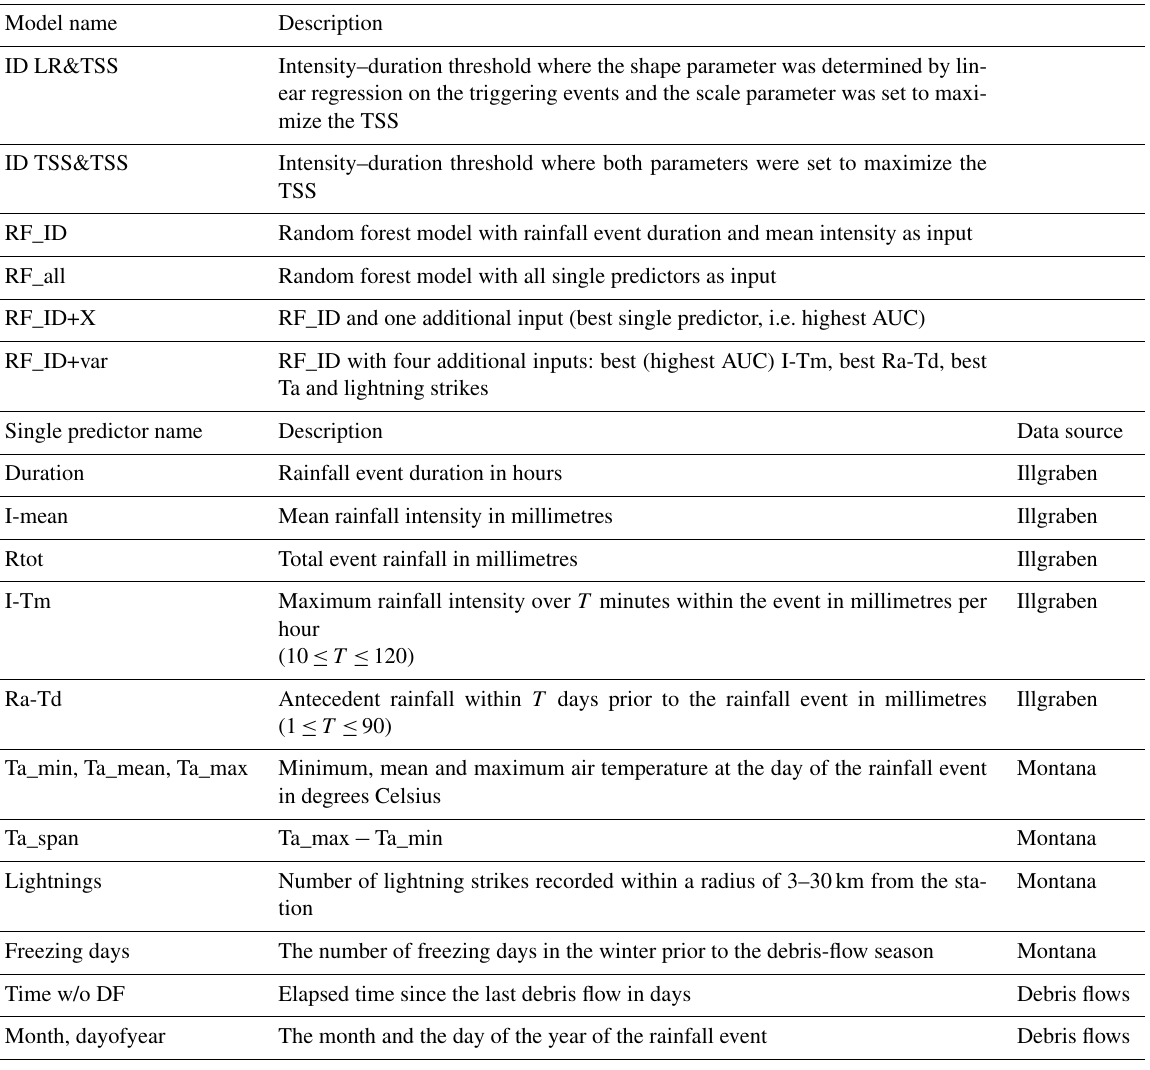
Table 1. List of models and single predictors evaluated on their predictive performance for debris flow triggering. Data source “Illgraben” refers to the local rain gauge, “Montana” to the MeteoSwiss weather station located 11km from the catchment and “Debris flows” to the Illgraben debris-flow data